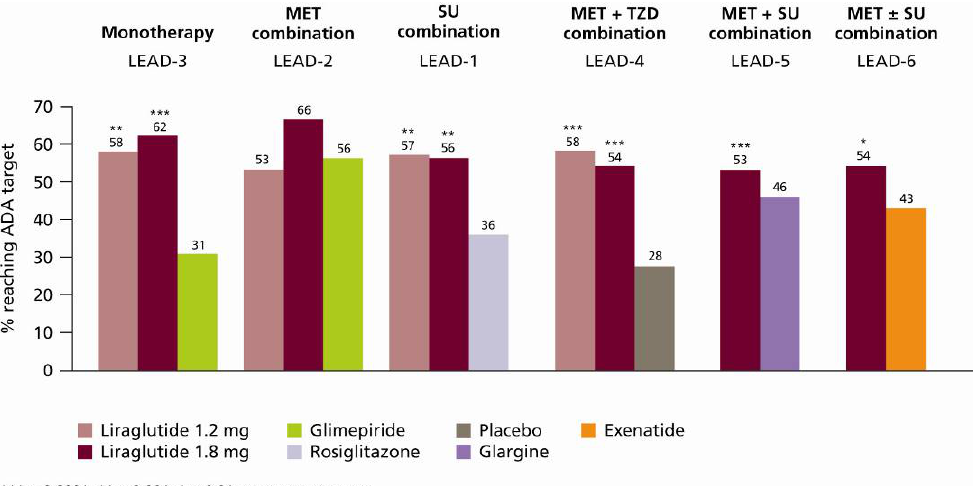
Figure 8. Percentage of Subjects Reaching ADA Target HbA Trials